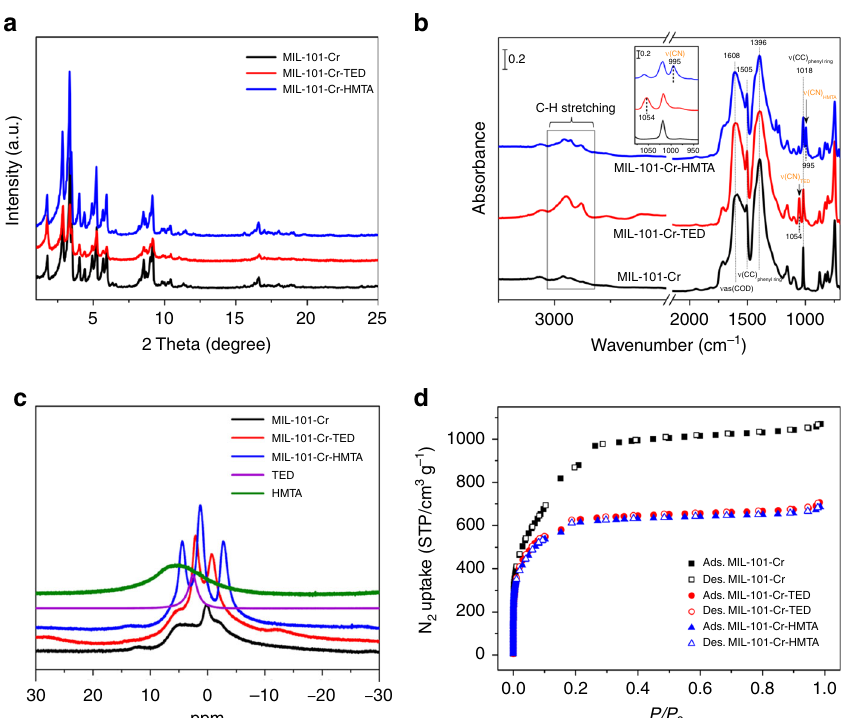
Fig. 2 Characterization of MIL-101-Cr and tertiary amine functionalized MIL-101-Cr. a PXRD patterns of MIL-101-Cr, MIL-101-Cr-TED, and MIL-101-Cr- HMTA. b FT-IR spectra of MIL-101-Cr, MIL-101-Cr-TED, and MIL-101-Cr-HMTA collected on samples after dehydration at 150 °C, the inset shows the mode associated with the C-N stretching vibration, at 1054 cm − 1 in MIL-101-Cr-TED and 995 cm − 1 in MIL-101-Cr-HMTA, based on refs 51, 52 . Note that the weak band at 1059 cm − 1 in MIL-101-Cr-HMTA spectrum is due to the CNC deformation vibration. The assignment of MOF phonon modes are based on ref. 53 . c Solid 1 H NMR spectra of MIL-101-Cr, TED, HMTA, MIL-101-Cr-TED, and MIL-101-Cr-HMTA. d N 2 sorption isotherms of MIL-101-Cr, MIL-101-Cr-TED, and MIL-101-Cr-HMTA collected at 77